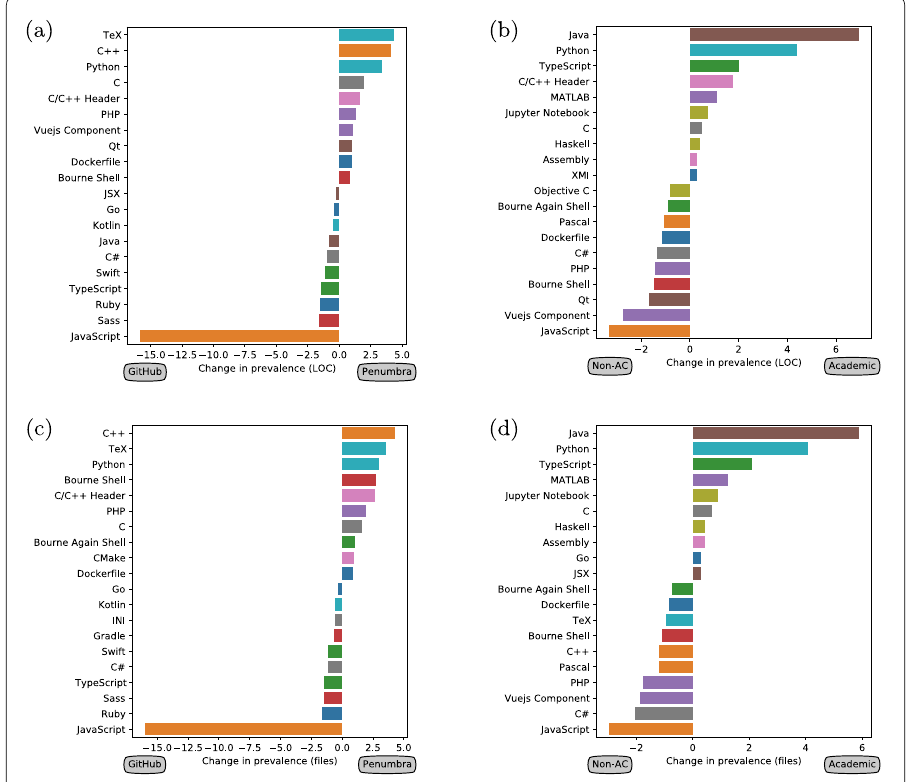
Figure 4 Dominant language domains in the Penumbra and GitHub. Comparison of language popularity, measured by lines of code (LOC) in panels ( a - b ) and by file count in panels ( c - d ). We count the top languages of each repository by the specified metric, normalize the results to a percentage of independent or GitHub repositories, then subtract the percentages. Therefore a language with a value of –0.05, for example, is the